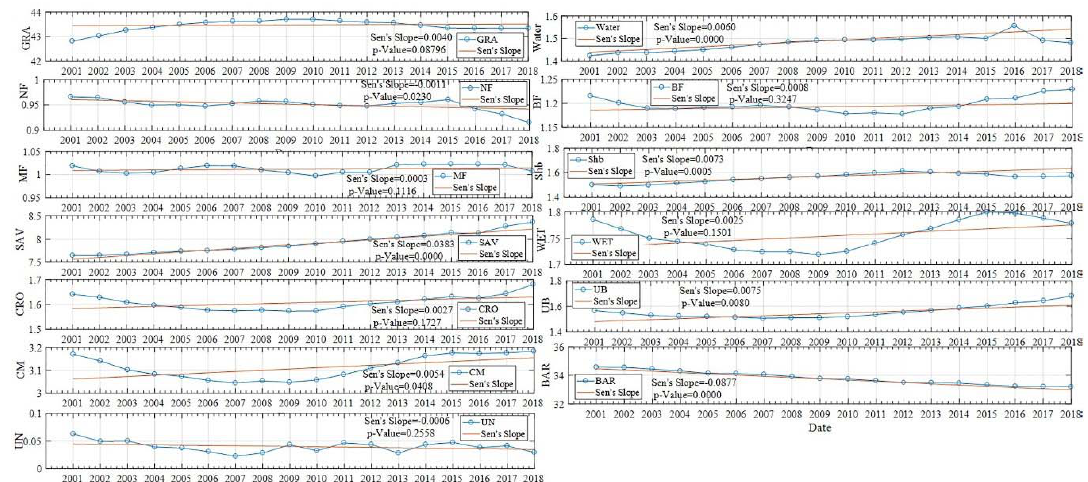
Figure 9. The evaluation of the percentage of land cover changes, spanning the years 2001 to 2019. WAR = Water bodies, MF = Mixed Forest, SAV = Savannas, WET = permanent Wetlands, CRO = Croplands, UB = Urban and Built-up lands, CM = Cropland / Natural Vegetation Mosaics, BAR = Barren and soil, UN =